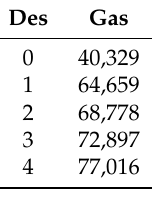
Table 8. Gas Used in singleRevocation()